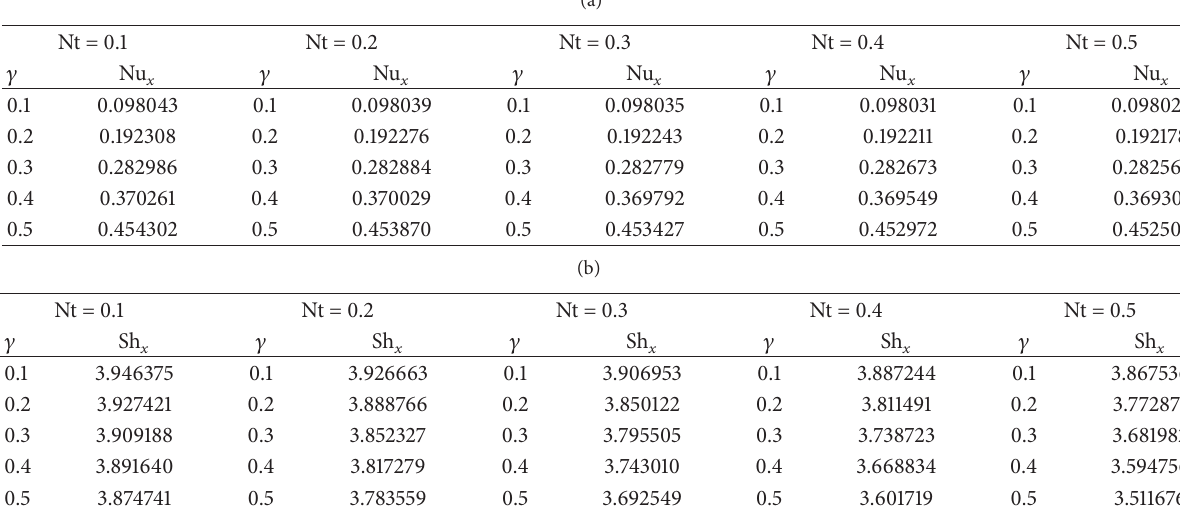
Table 3: (a) Variation of the local Nusselt number Nu 𝑥 with 𝛾 and Nt and (b) variation of the local Sherwood number Sh 𝑥 with 𝛾 and Nt for Nb = 0.5, Le = 2, and Pr =